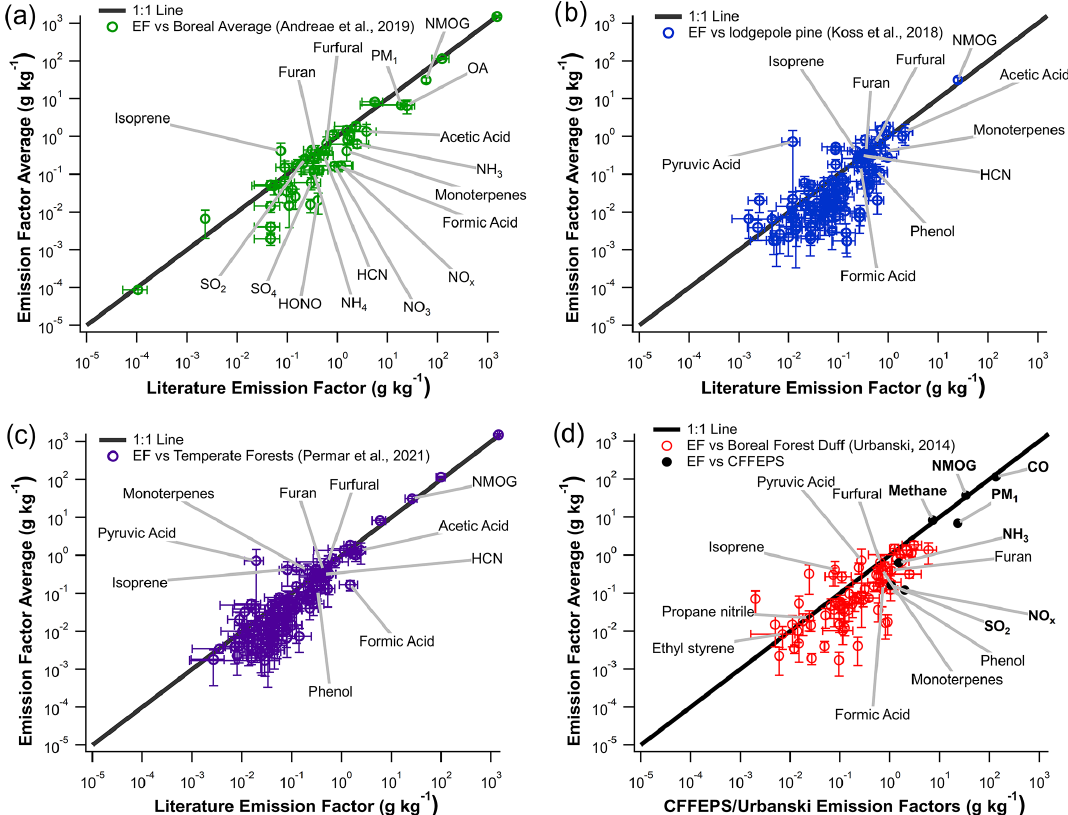
Figure 9. Comparison of averaged emission factors with (a) boreal forest field-based measurements (Andreae, 2019; Akagi et al., 2011; Liu et al., 2017), (b) laboratory-based measurements of lodgepole pine (Koss et al., 2018), (c) temperate forest field-based measurements (Permar et al., 2021), and (d) those used in CFFEPS (Urbanski, 2014). See Table S8 in the Supplement for compound comparisons that do not have exact